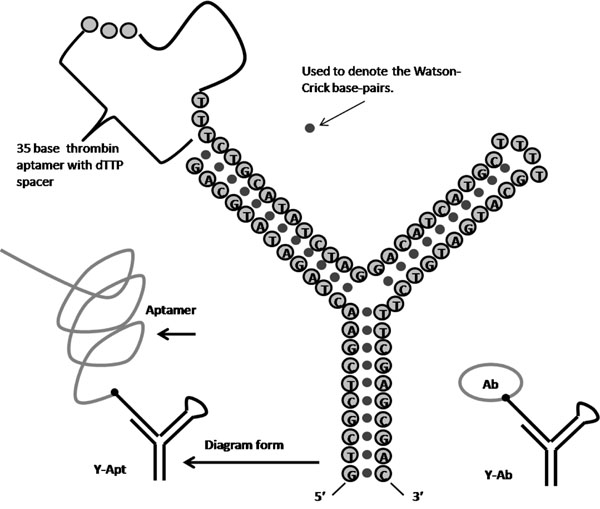
The thrombin aptamer from [52] is 5’-CACTGGTAGGTTGGTGTGGTTGGGGCCAGTG-3’.